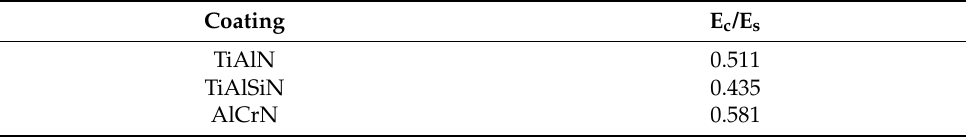
Table 7. E c /E s ratio determined for each of the tested